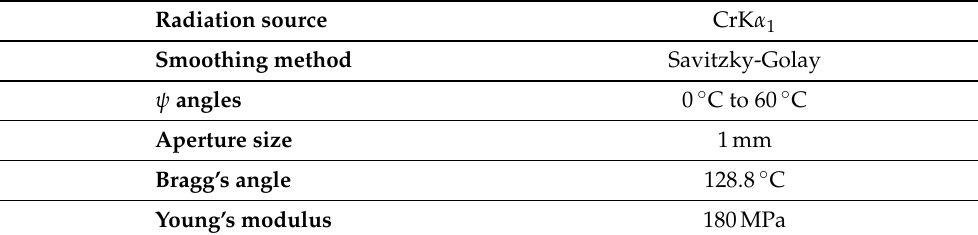
Table 2. XRD parameters of residual stress measurements on LSP-treated AISI